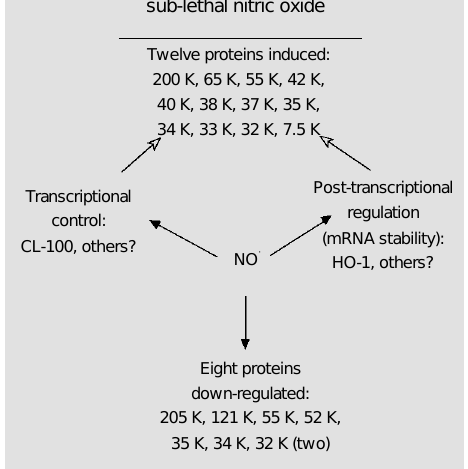
Figure 3 - Constellation of nitric oxide (NO)-inducible proteins in human IMR-90 fibroblasts. HO- 1, Heme oxygenase 1. Re- printed with permission from Ref.